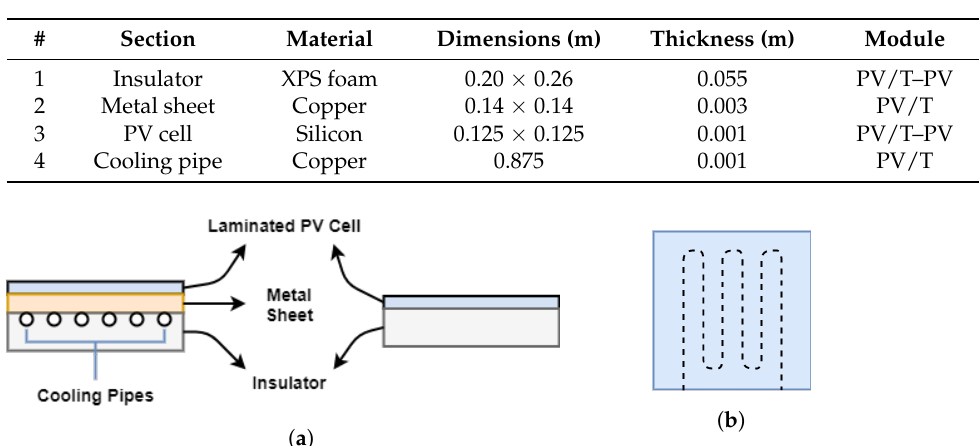
Table 3. Components of PV/T and PV modules and their physical properties.